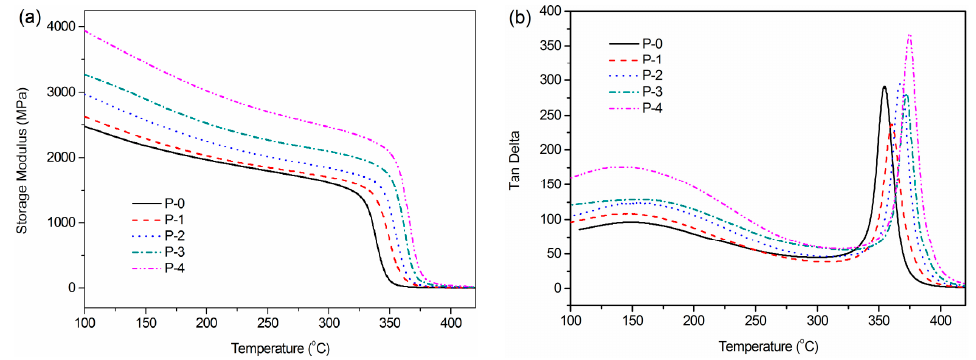
Figure 8. DMA measurement for CPEN/F-BaTiO 3 composite films with different F-BaTiO 3 loading: ( a ) the storage modulus; and ( b ) tan δ of composite films versus temperature.